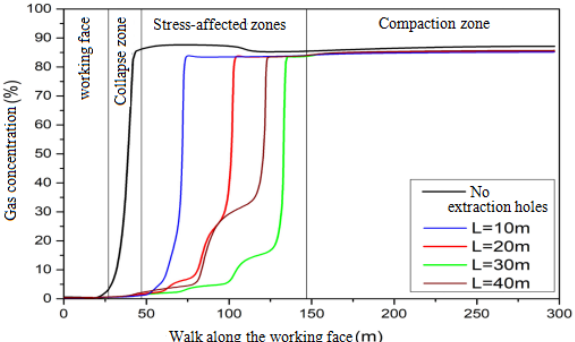
Figure 5. Methane concentration distribution along the center line of the return airway at different borehole spacing.